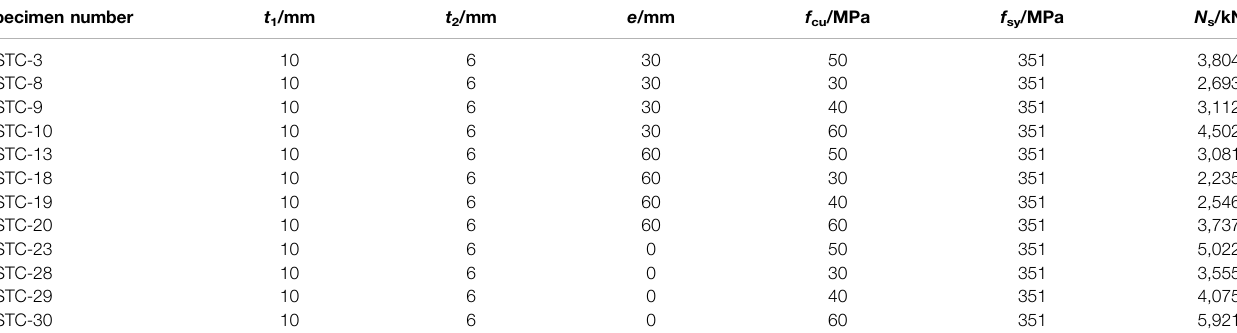
TABLE 8 | Ultimate eccentrical compression bearing capacity of specimens with different compressive strengths of concrete cubes. Specimen number